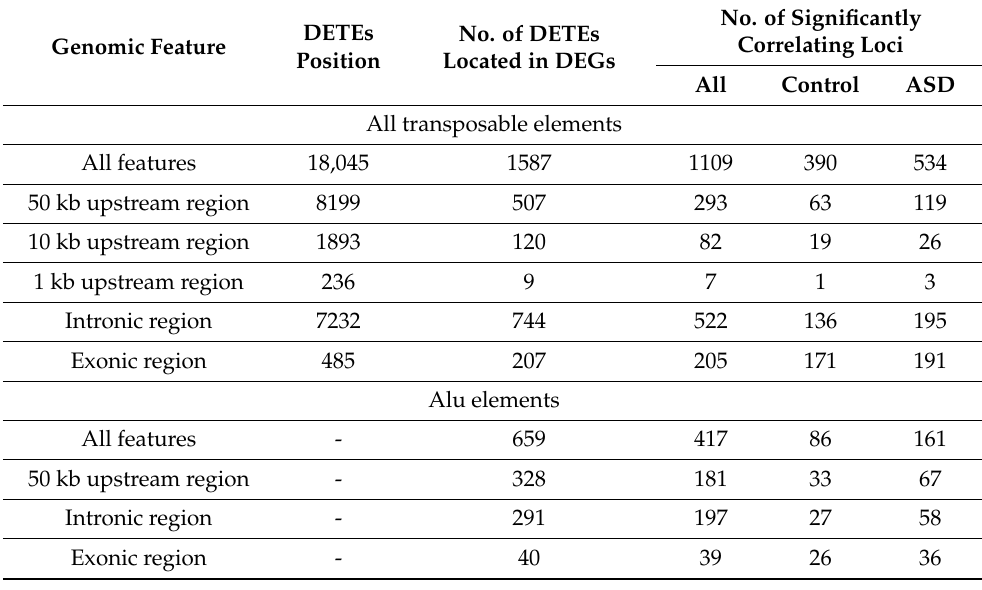
Table 1. Number of DETE loci used for correlation with their hosts/nearby DEGs in the prefrontal cortex of ASD individuals. DETE loci were classified based on genomic features and considered significant by a Benjamini–Hochberg (BH)-adjusted p < 0.05.